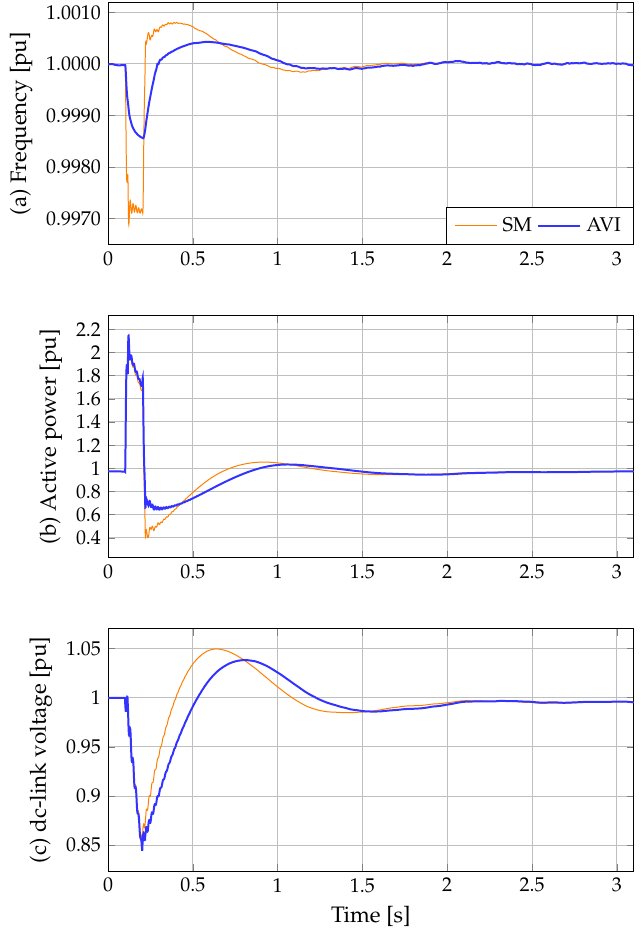
Figure 6. Dynamic responses for case 1: ( a ) frequency, ( b ) active power, and ( c ) dc-link voltage. Table 4. Performance